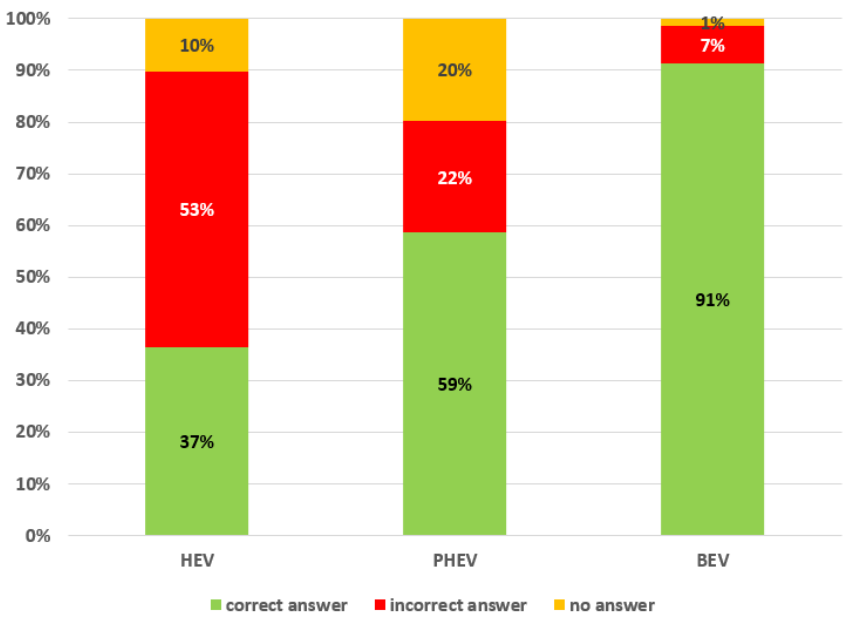
Figure 6. Frequencies of knowledge regarding type of fuels for HEV, PHEV and BEV (N = 1002).